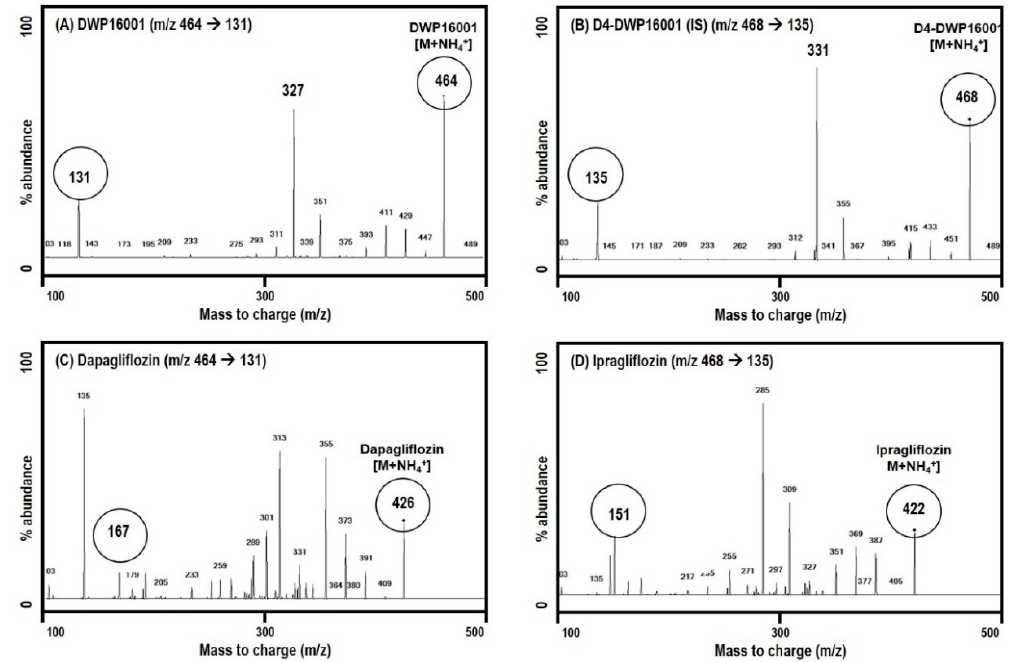
Figure 2. Product ion spectra of ( A ) DWP16001, ( B ) D4-DWP16001 (IS), ( C ) dapagliflozin, and ( D ) ipragliflozin.